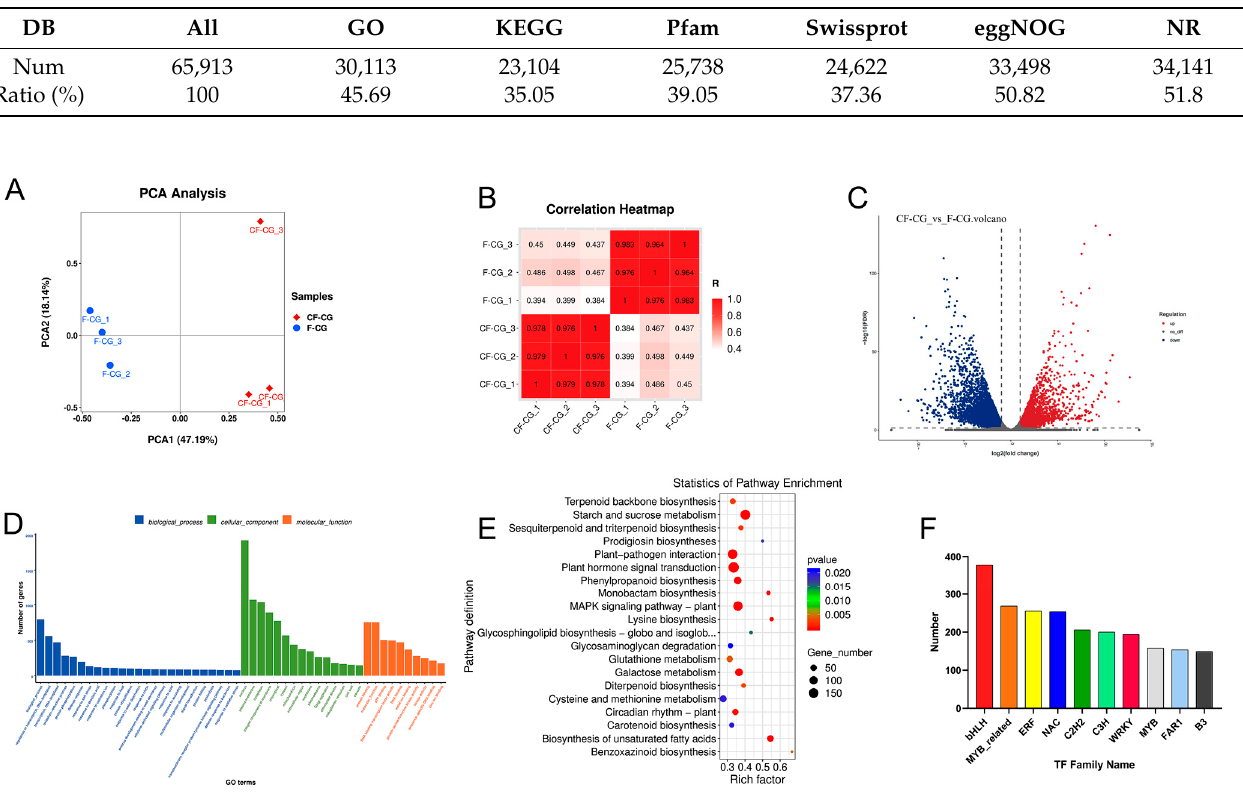
Figure 5. Basic genetic information of F-CG and CF-CG based on transcriptomics. ( A ): Principal component analysis of genes identified in F-CG and CF-CG. ( B ): Correlation analysis of F-CG and CF-CG samples. (Color indicates the level of correlation for each sample, from low (pink) to high (red), and Z score indicates the correlation coefficient between every two samples.) ( C ): Volcano plot showing differentially accumulated genes (DAGs) up-regulated, down-regulated or unchanged between F-CG and CF-CG samples. ( D ): GO enrichment analysis of DAGs for F-CG and CF-CG samples. ( E ): KEGG enrichment analysis of DAGs for F-CG and CF-CG samples. F : A family of differentially expressed transcription factors in F-CG and CF-CG.